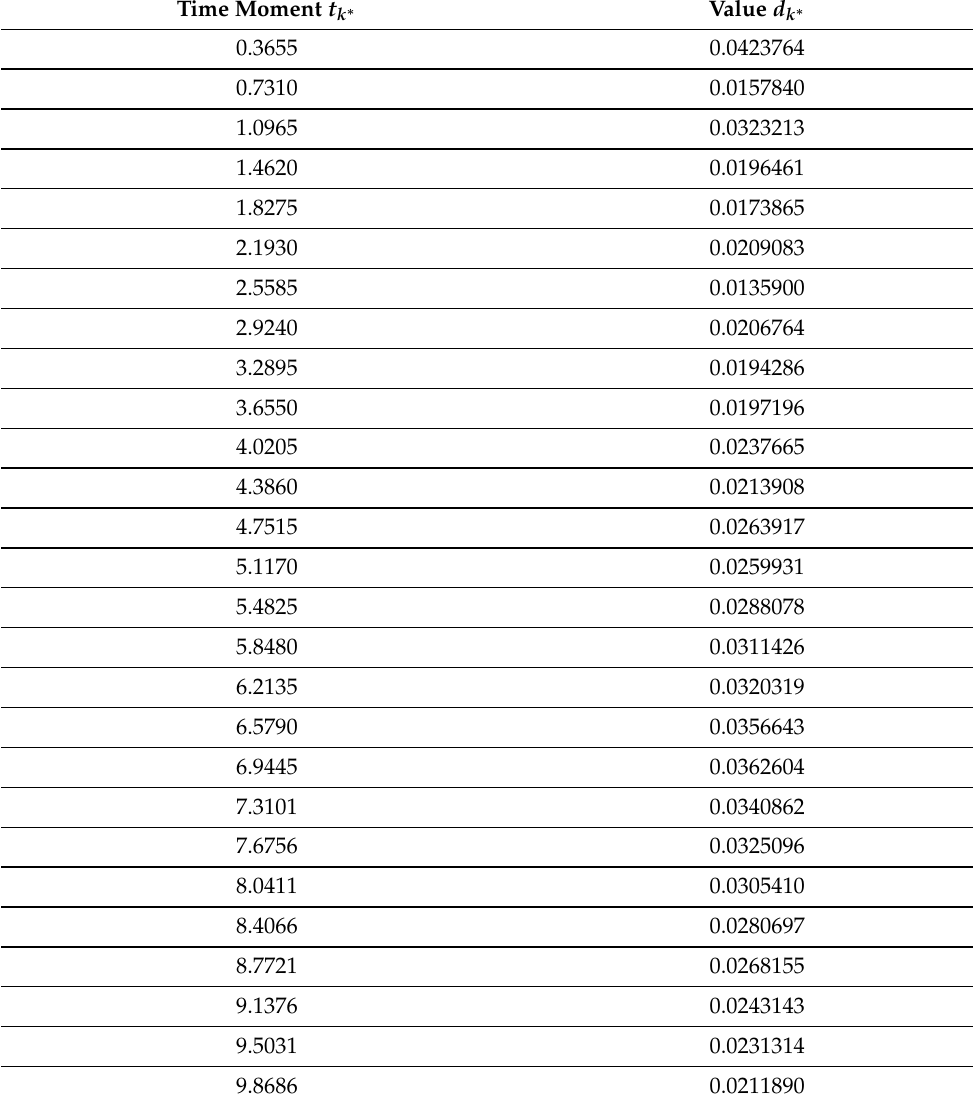
Table 3. Table 1. The Poincaré recurrences for the point (9), ∆ t P = 10 − 4 , T = 15 for reachingthe attractor. Time Moment t k